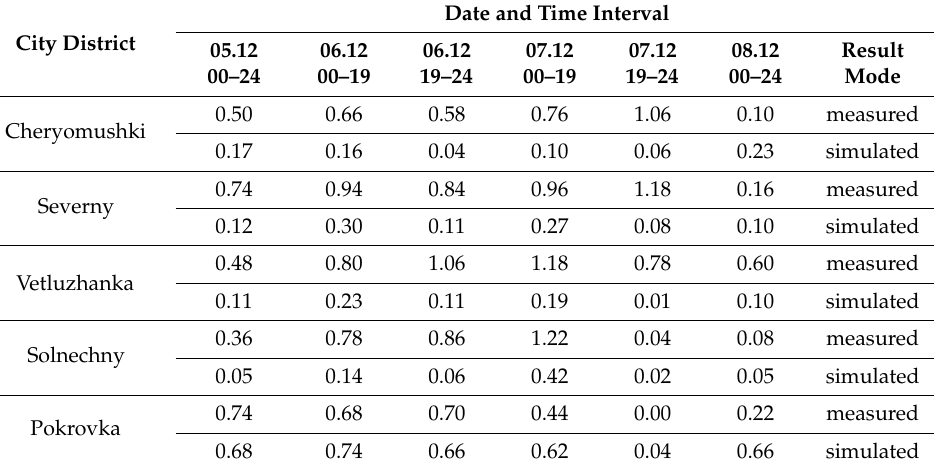
Table 8. CO concentrations in shares of peak MPC (5000 µ g / m 3 ).